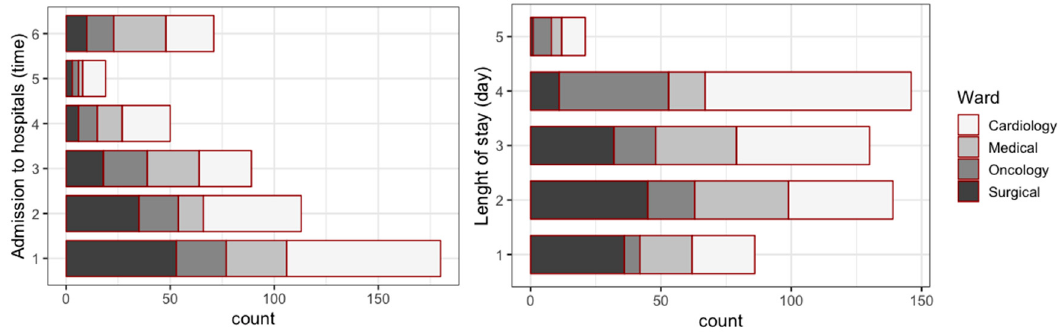
Figure 2. Patient health profiles classified per ward.